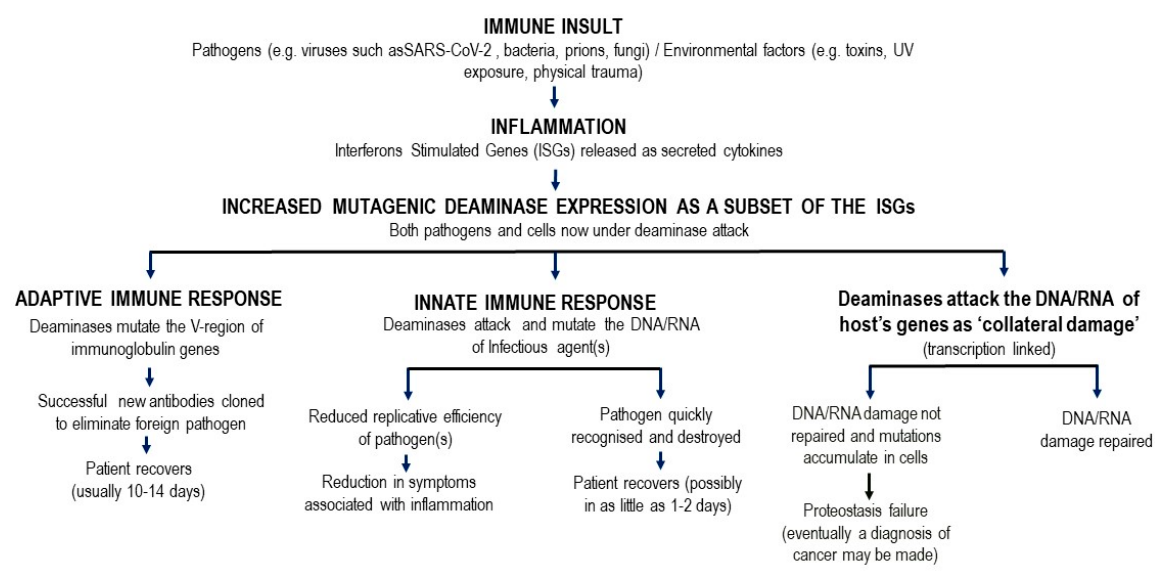
Figure 1. Model linking downstream innate and adaptive immune changes following pathogen insult. The mechanism(s) involved in training innate immunity likely involve epigenetic changes (altered DNA methylation; histone deacetylase activity) which results in